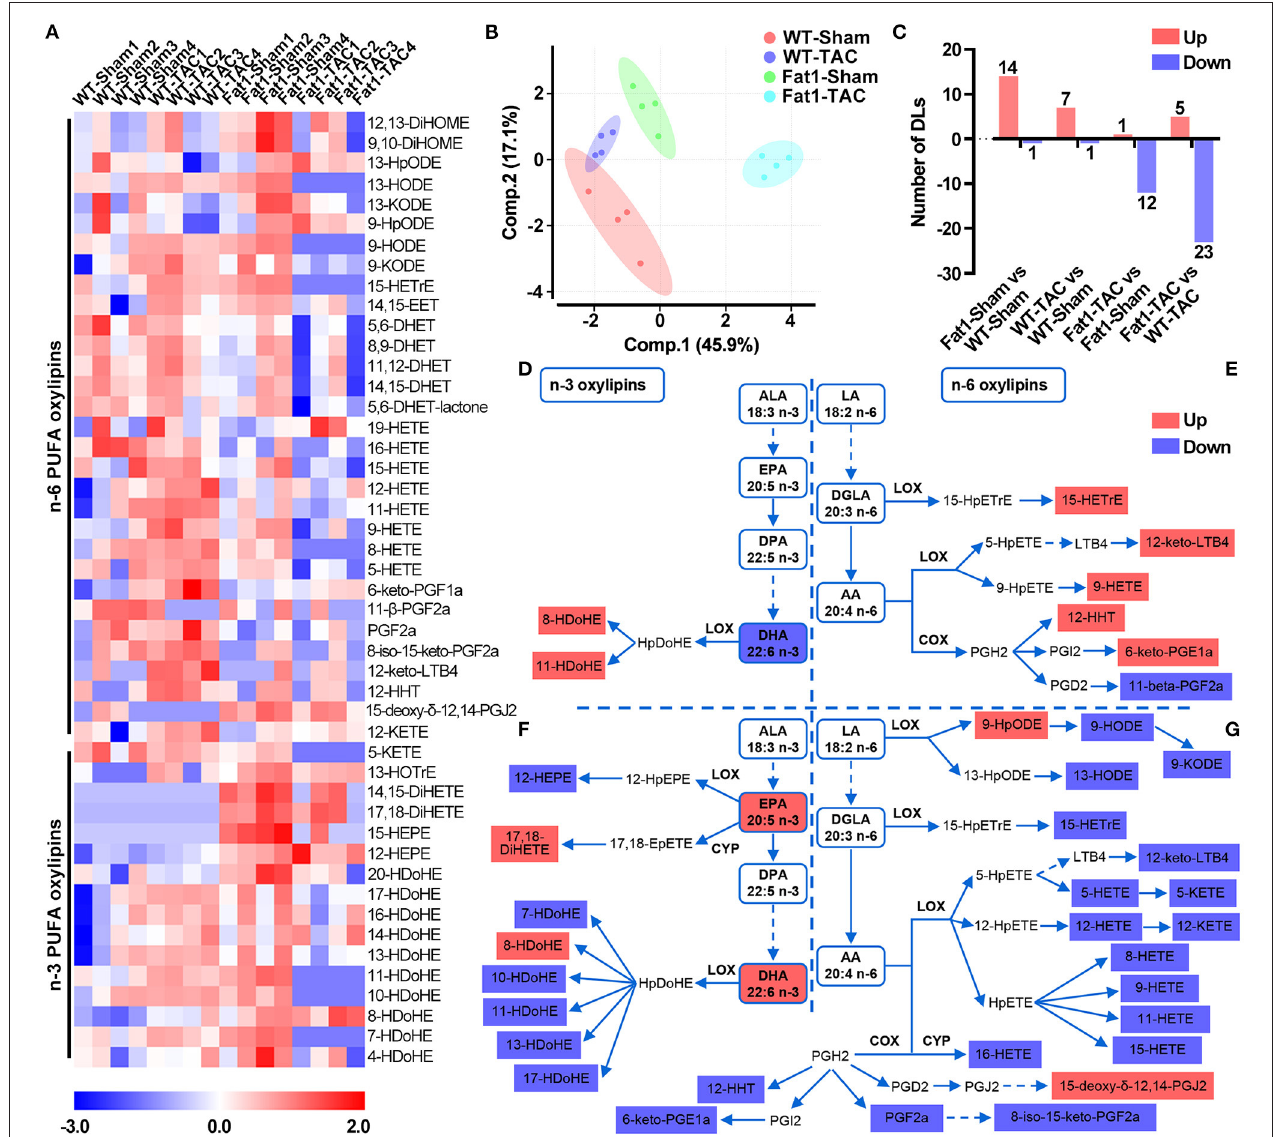
FIGURE 5 | Signature of myocardial n-3/n-6 PUFA oxylipins in WT and fat-1 transgenic hearts under pressure overload conditions. Profile shifts of n-3 and n-6 oxylipins (A) were observed in the myocardium. The principal component analysis plot (B) showed that the altered profiles were distinct between groups, and the counts of altered oxylipins are shown in (C) . In the n-3 metabolic pathway, pressure overload reduced DHA levels but increased the levels of its oxylipins 8- and 11-HDoHE in the hearts of WT mice (D) . In the n-6 PUFA metabolic pathway, pressure overload increased the levels of 5 oxylipins, and decreased 1 oxylipin in the n-6 PUFA pathway (E) . Compared with WT hearts, the n-3 PUFA-protected hearts showed higher concentrations of EPA, DHA, and two oxylipins, whereas lower concentrations of 6 oxylipins were observed under pressure overload conditions (F) . Compared to WT hearts, fat-1 hearts increased the levels of 2 of oxylipins but decreased 18 oxylipins in the n-6 PUFA pathway (G) . N = 4 for each